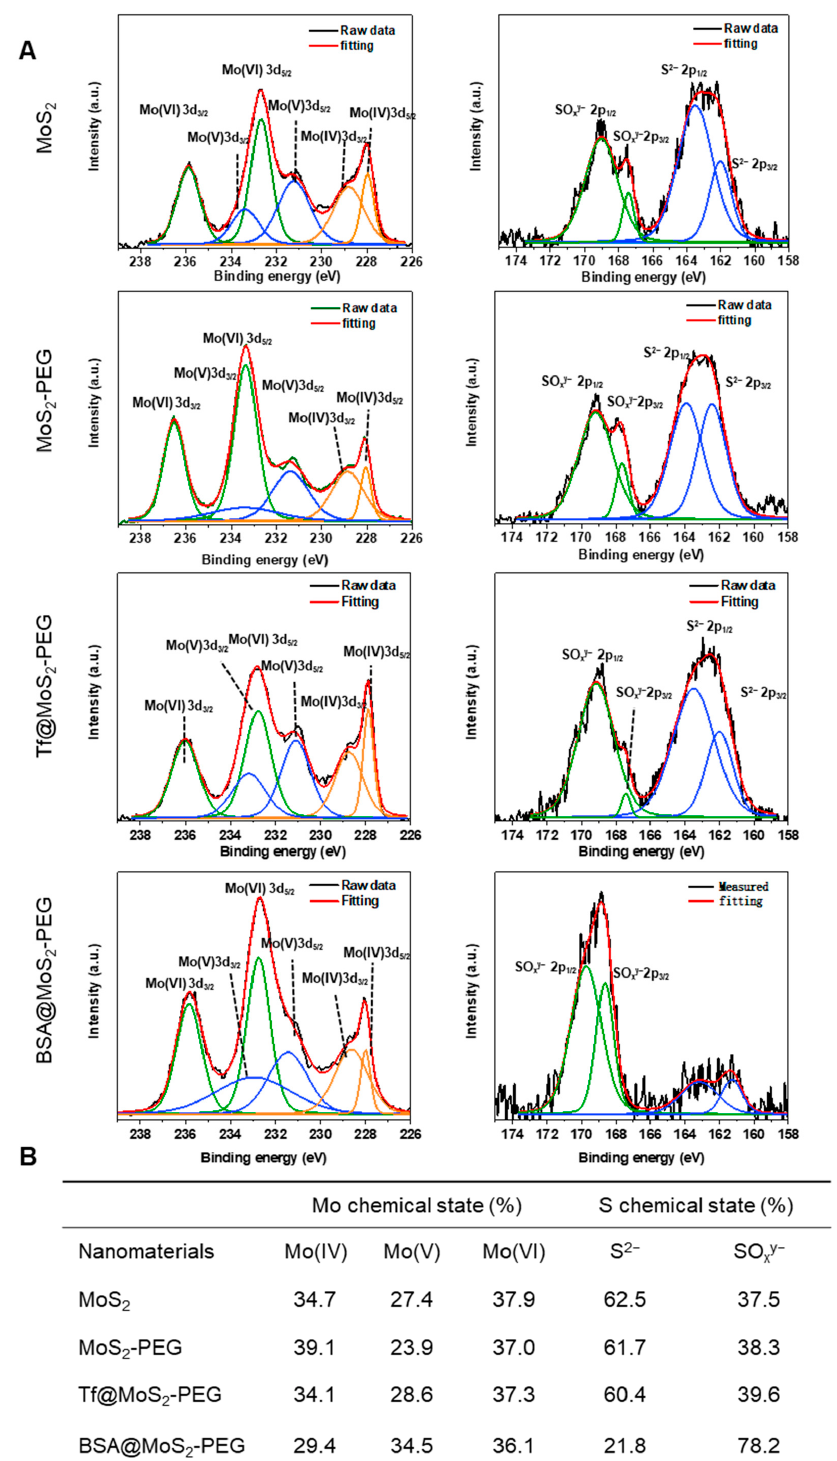
Figure 3. ( A ) High-resolution XPS spectra of Mo 3d and S 2p in MoS 2 , MoS 2 − PEG, Tf@ MoS 2 − PEG, and BSA@MoS 2 − PEG. ( B ) Quantitative results of Mo and S chemical states in MoS 2 , MoS 2 − PEG, Tf@ MoS 2 − PEG, and BSA@MoS 2 − PEG. The green, blue, and orange color spectra components were attributed to Mo(VI), Mo(V), and Mo(IV)